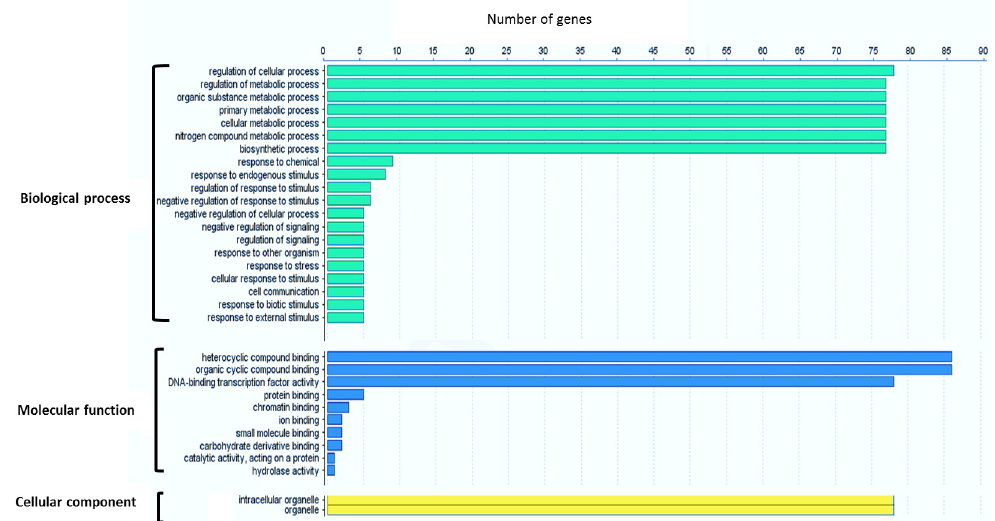
Fig 5. Gene ontology analysis of identified Sb WRKYs. The enrichment analysis shows the involvement of Sb WRKY in biological processes, molecular functions, and cellular